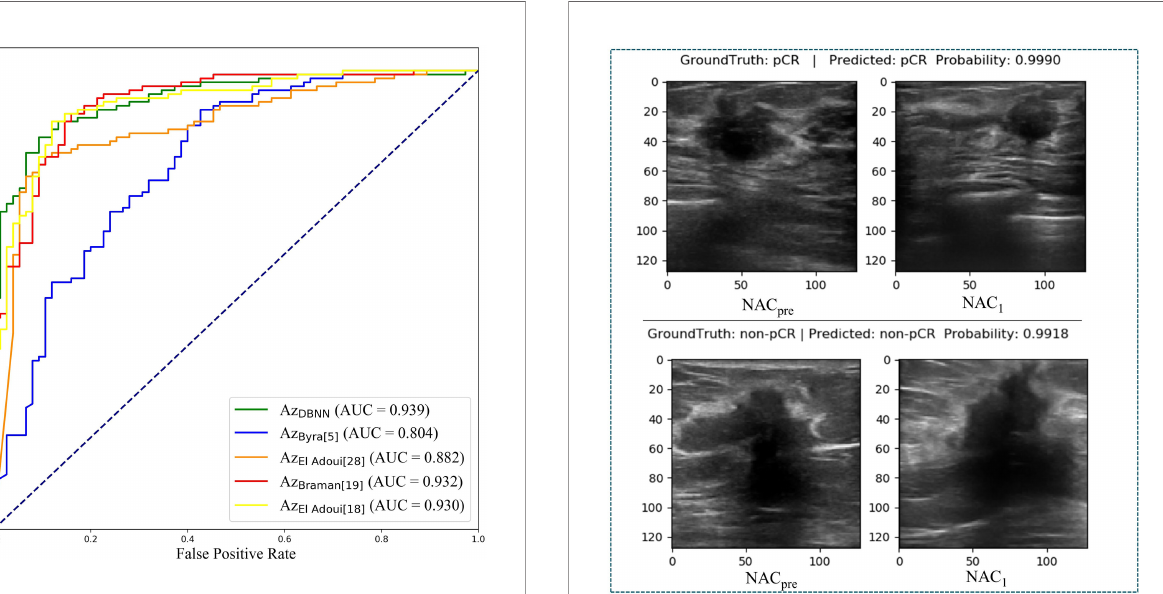
TABLE 10 | Comparison of DBNN and other NAC prediction methods on the RJNAC dataset. Methods